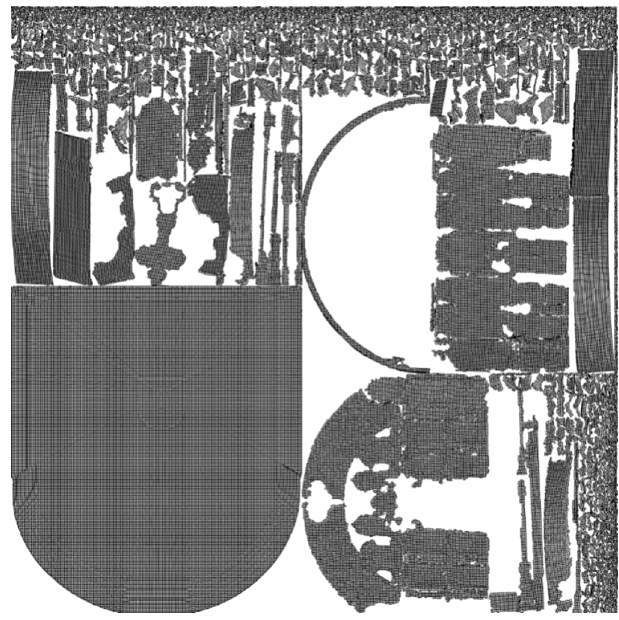
Figure 6. Iconostasis UV map from Blender.